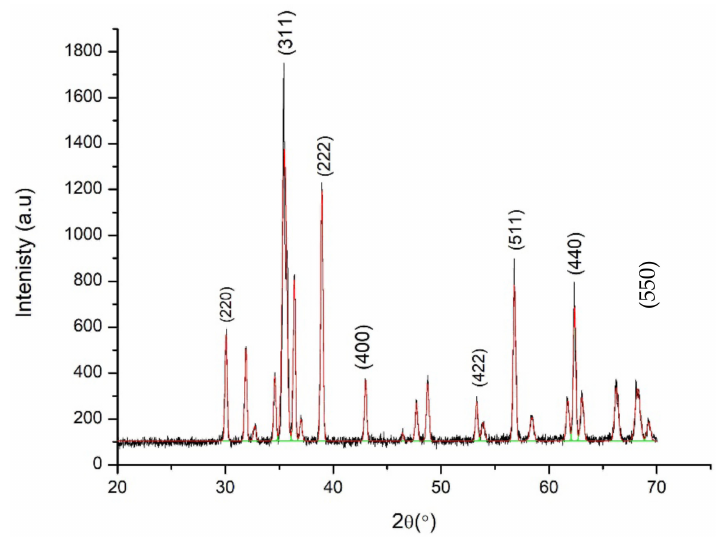
Figure 1. XRD patterns with Rietveld refinement the Cu 0.5 Zn 0.5 Fe 2 O 4